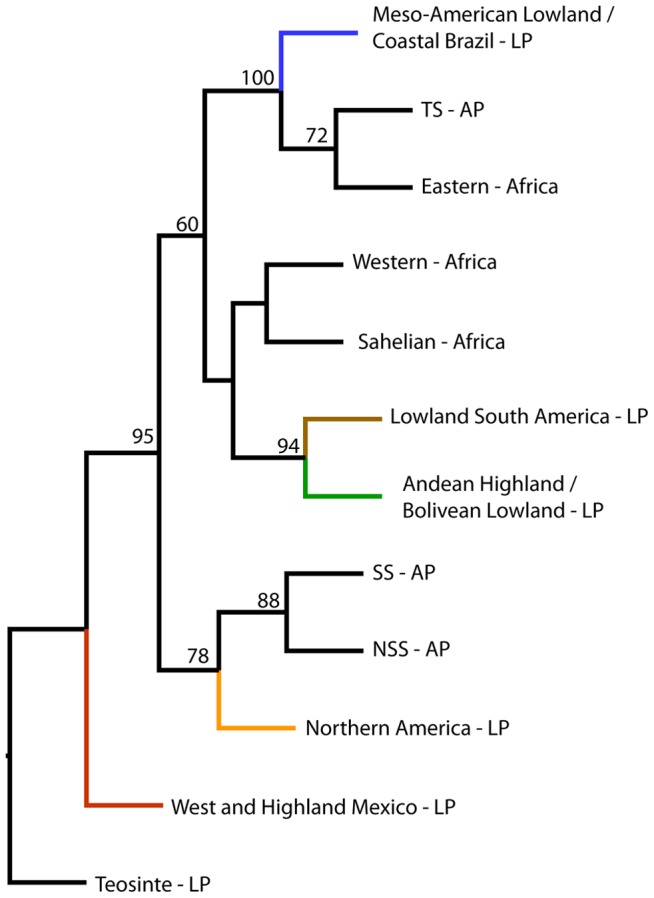
Relationship between African maize and global reference panels.Rooted Neighbor-joining tree of the combined African panel (Eastern, Sahelian, and Western Africa), Association Panel (NSS, SS and TS) and Landrace Panel (branches are named and coloured according to the clusters identified with K = 5 in the STRUCTURE analysis) based on 259 SNPs with bootstrap values in % from 1000 replications.